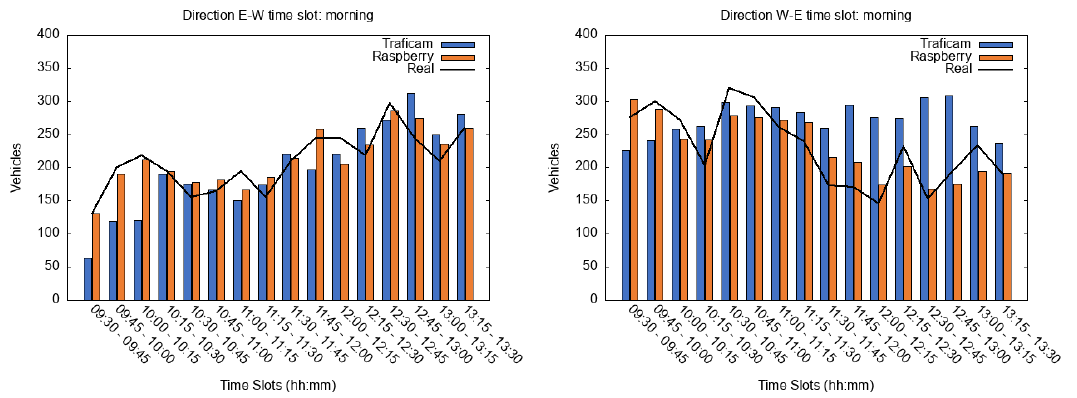
Figure 8. Comparison of Traficam (in blue) and Edge device (in orange) for vehicle counting during the morning time slot. On left part of the figure the direction E-W is shown, on the right part the direction is W-E.